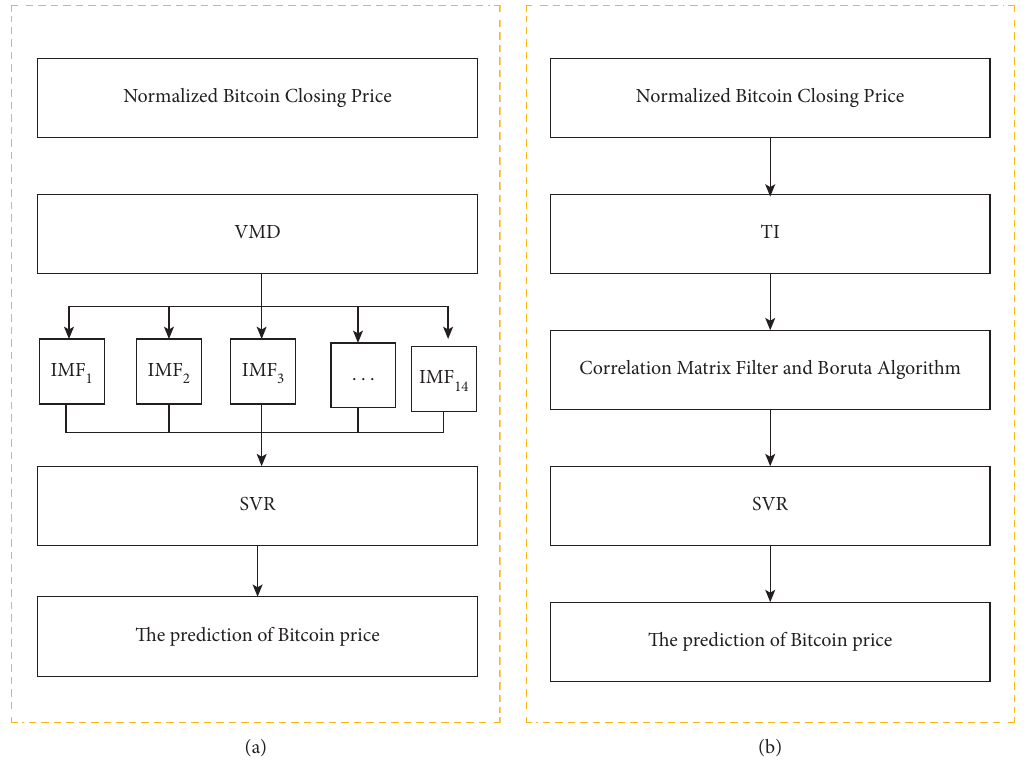
Figure 3: Details of SVR-rVMF and SVR-TI. (a) SVR-rVMF. (b) SVR-TI.